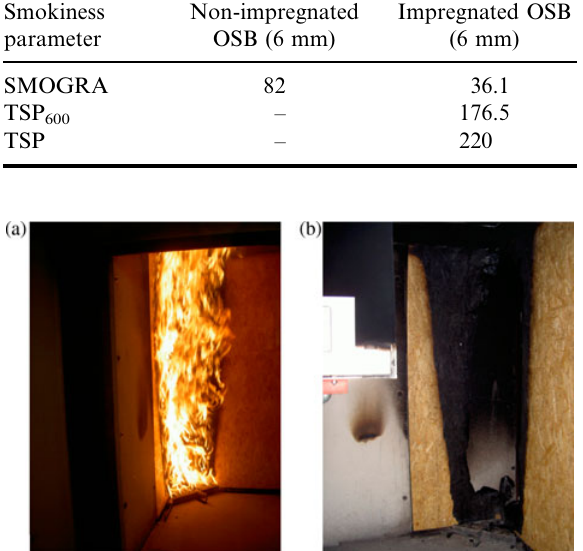
Fig. 10. CO 2 release test results of impregnated (BAK-1) and non-impregnated 6-mm-thick OSB and 24-mm-thick